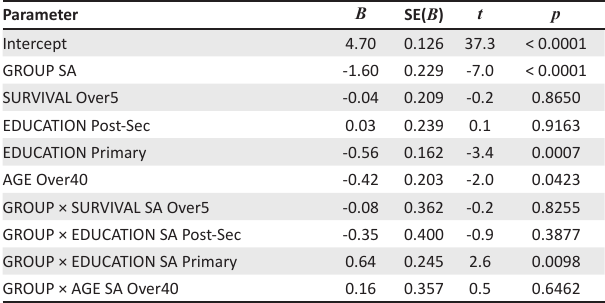
TABLE 6: Parameter estimates for two-way interaction analysis of variance model of use of broadcast media. Parameter Intercept